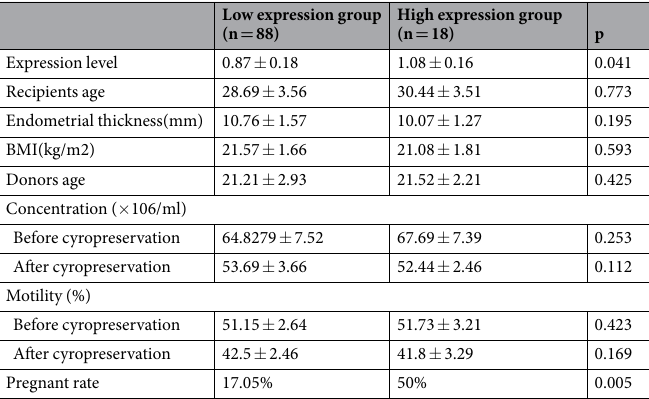
Table 2. Parameters of female recipients and routine parameters of semen sample applied for treatment between the low- and high- expression